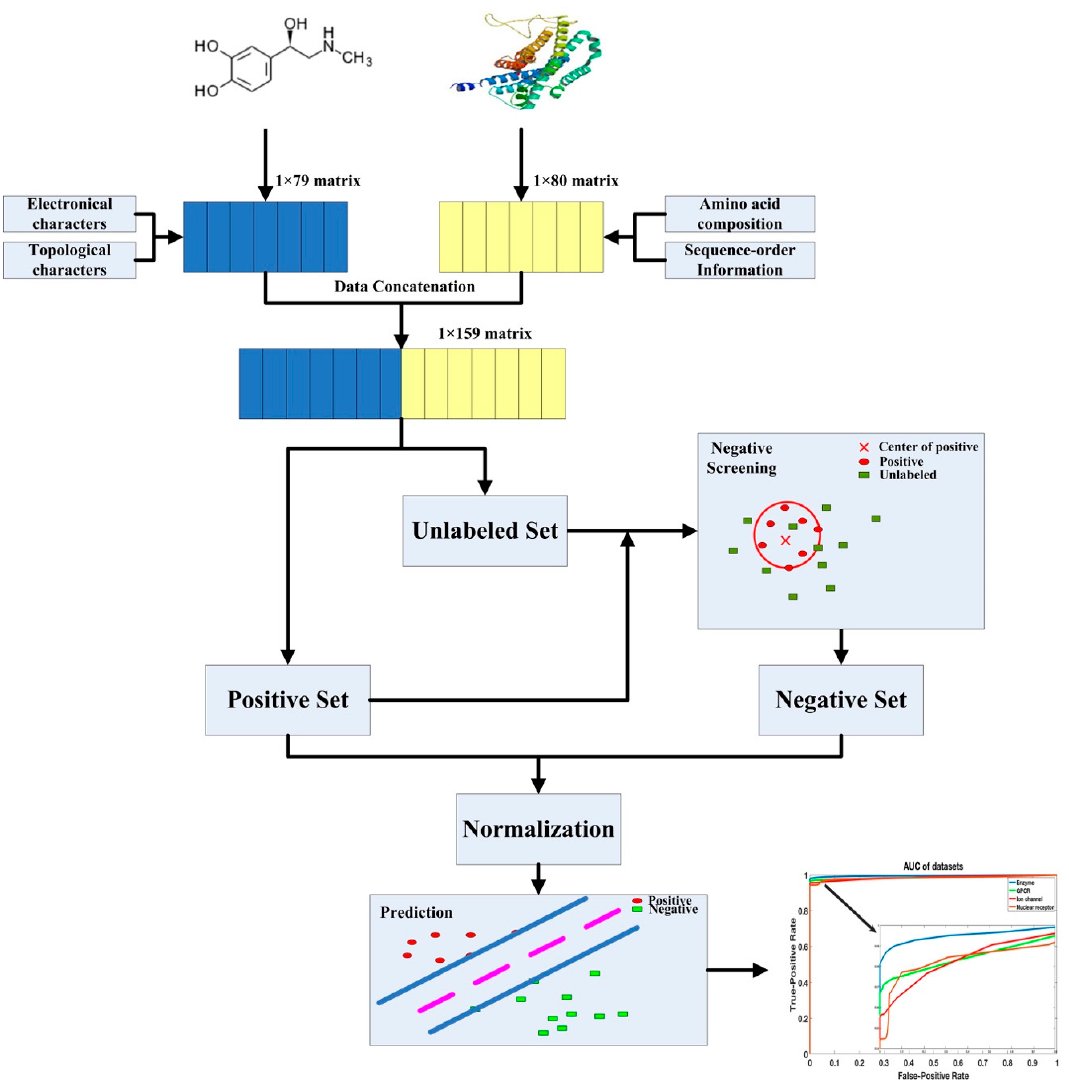
Figure 6. The flowchart of proposed method.